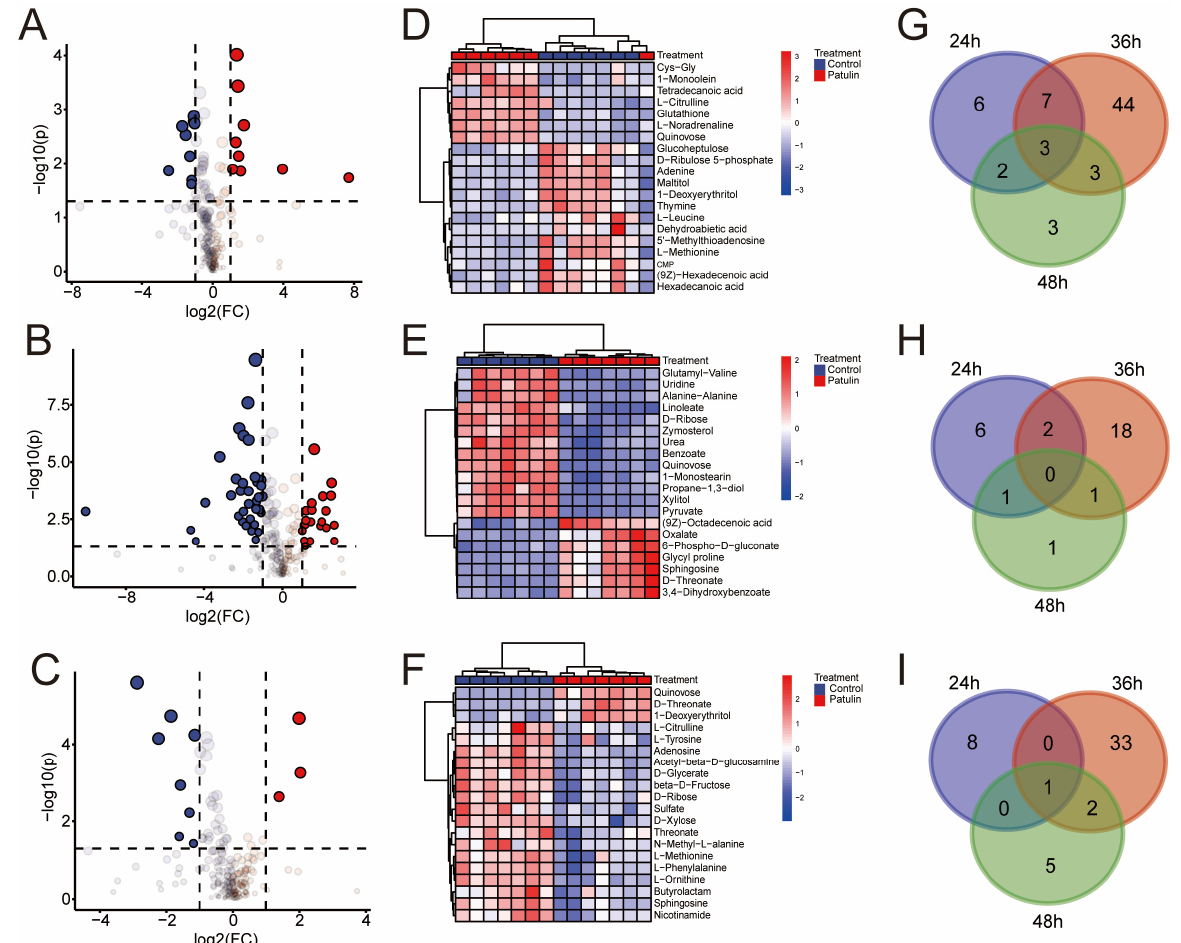
Figure 4. Subfigures ( A – C ) are the volcano plots of control group and patulin treatment groups at different degradation times, for which the up-regulated (red), down-regulated (blue), and non-regulated (grey) groups were determined based on the fold change ≥ 2 or fold change ≤ 0.5, employing a p -value < 0.05: ( A ) 24 h; ( B ) 36 h; ( C ) 48 h. ( D – F ) are the heatmaps of control group and patulin treatment groups at different degradation times, wherein the top twenty different metabolites with a VIP-value > 1 were selected for display: ( D ) 24 h; ( E ) 36 h; ( F ) 48 h. ( G – I ) are Venn diagrams depicting the shared and specific metabolites between the different groups of A. niger FS10: ( G ) total accumulated metabolites; ( H ) up-accumulated metabolites; ( I ) down-accumulated metabolites. MetaboAnalyst 5.0 was used to analyze the pathway mapping of the p -value < 0.05